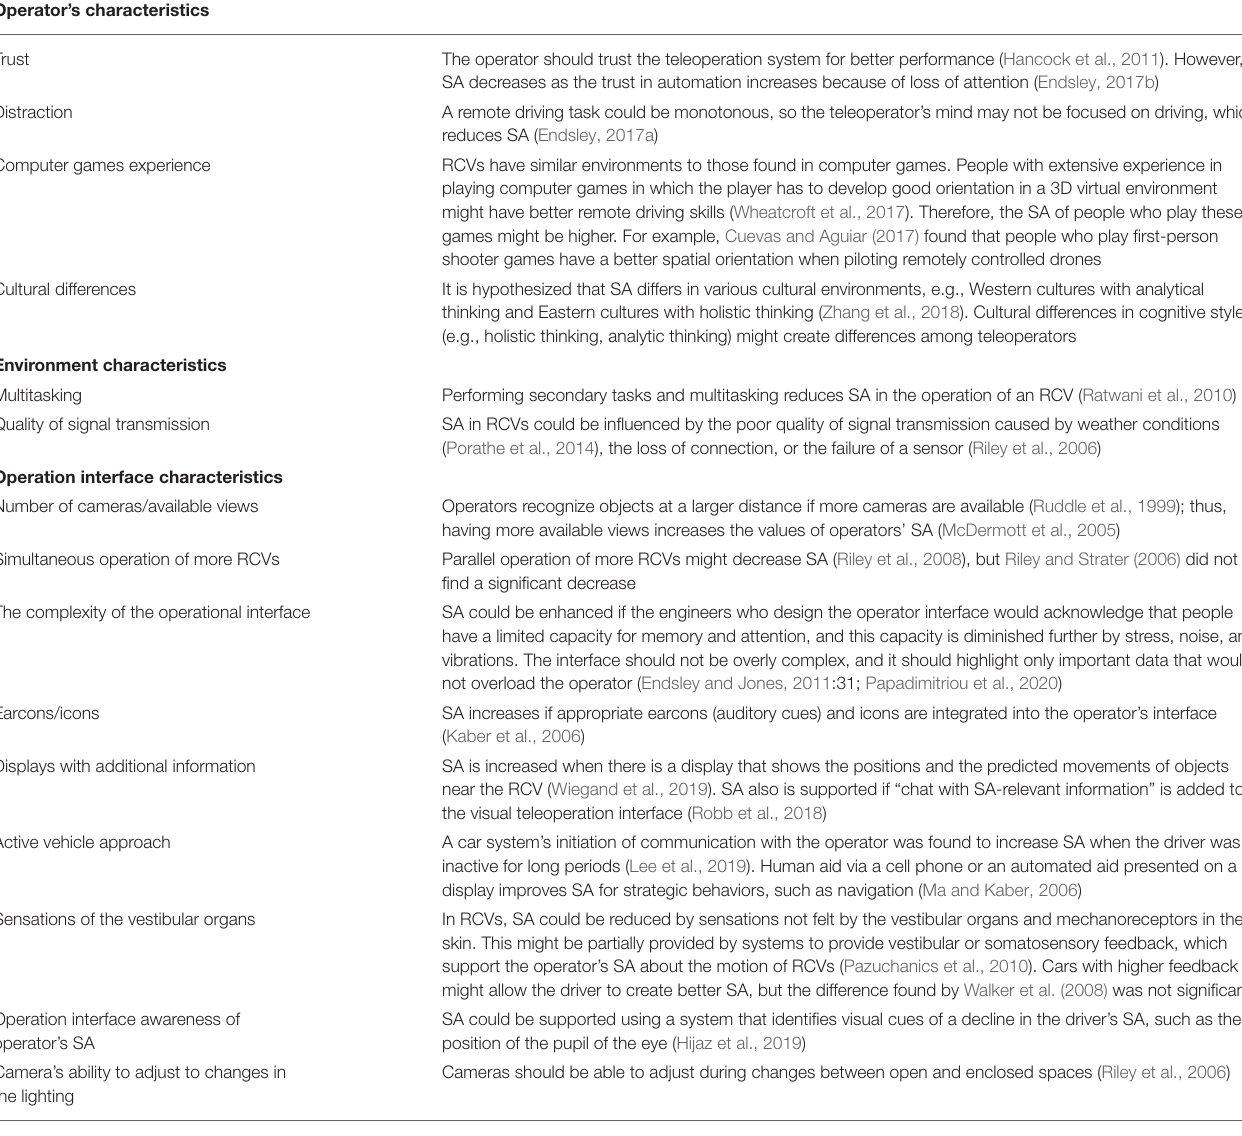
TABLE 2 | Remotely controlled vehicle (RCV) operator, environment, and operation interface characteristics that influence a teleoperator’s situational awareness (SA). Operator’s